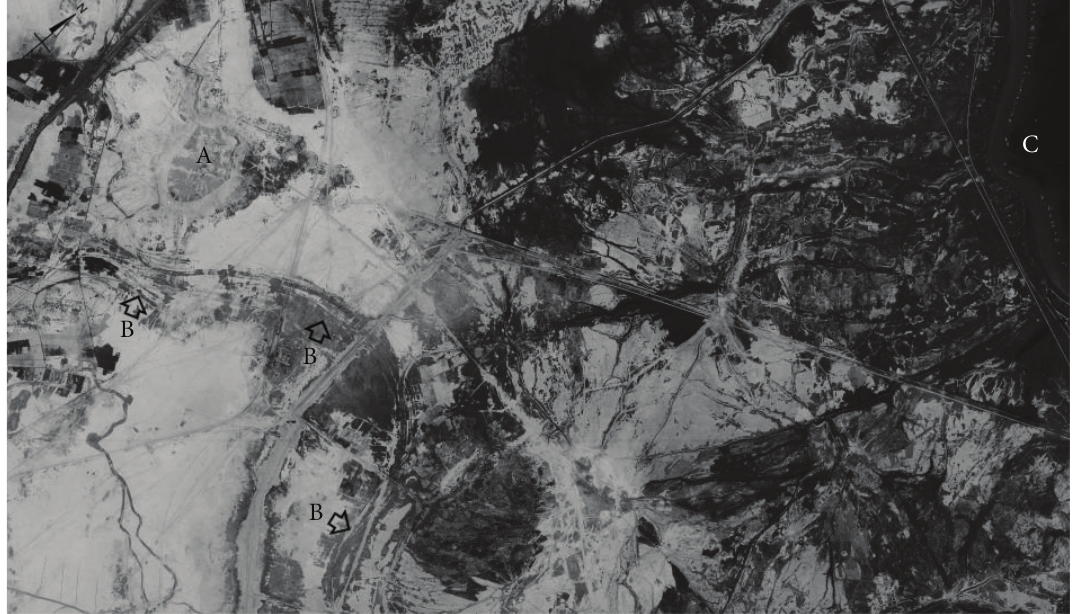
Figure 4: The territory of Ur (A) in a Gambit KH-7 photograph taken in April 1966: the traces of a paleoriver bed of the Euphrates (B) and the present river bed (C) are